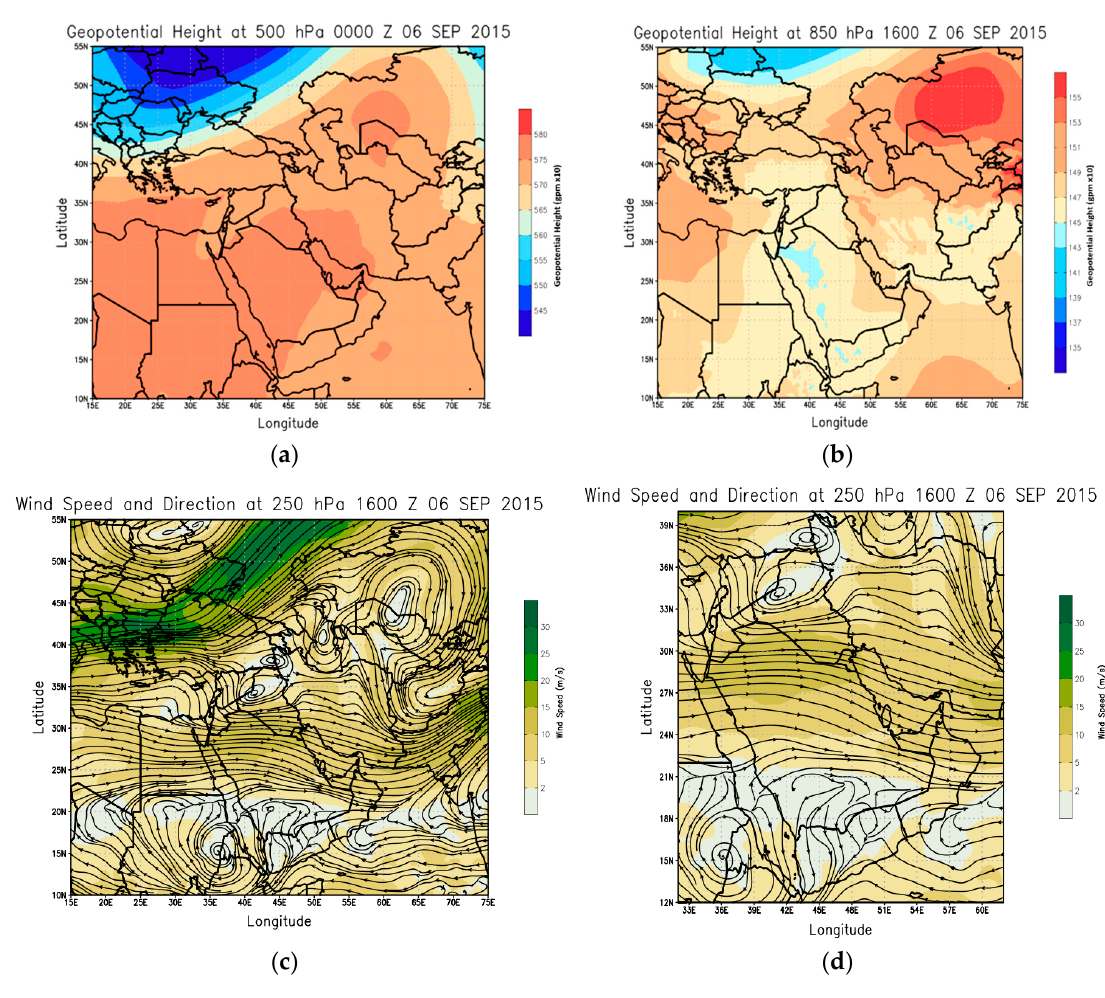
Figure 9. ECMWF ERA5 re-analyses of: ( a ) Geopotential height on 6 September 2015 at 0000UTC at 500 hPa. ( b ) Geopotential height on 6 September 2015 at 1600UTC at 850 hPa. ( c ) Wind speed (colors) and wind direction (streamlines) at 250 hPa on 6 September 2015 at 1600UTC (c), ( d ) same as (c) but zoomed over the area of interest.